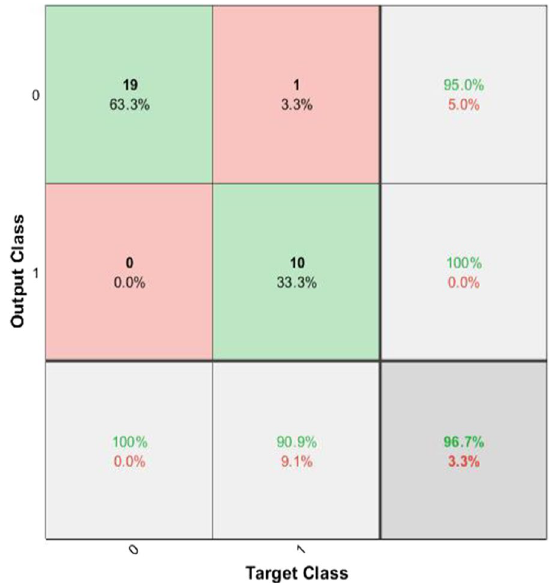
Fig. 8 The hybrid classifier’s confusion matrix